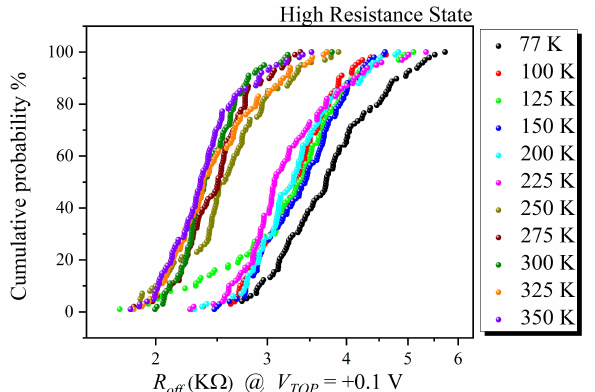
Figure 5. R of f @ V TOP = +0.1 V cumulative probability measured at different temperatures ranging from 78 K to 350